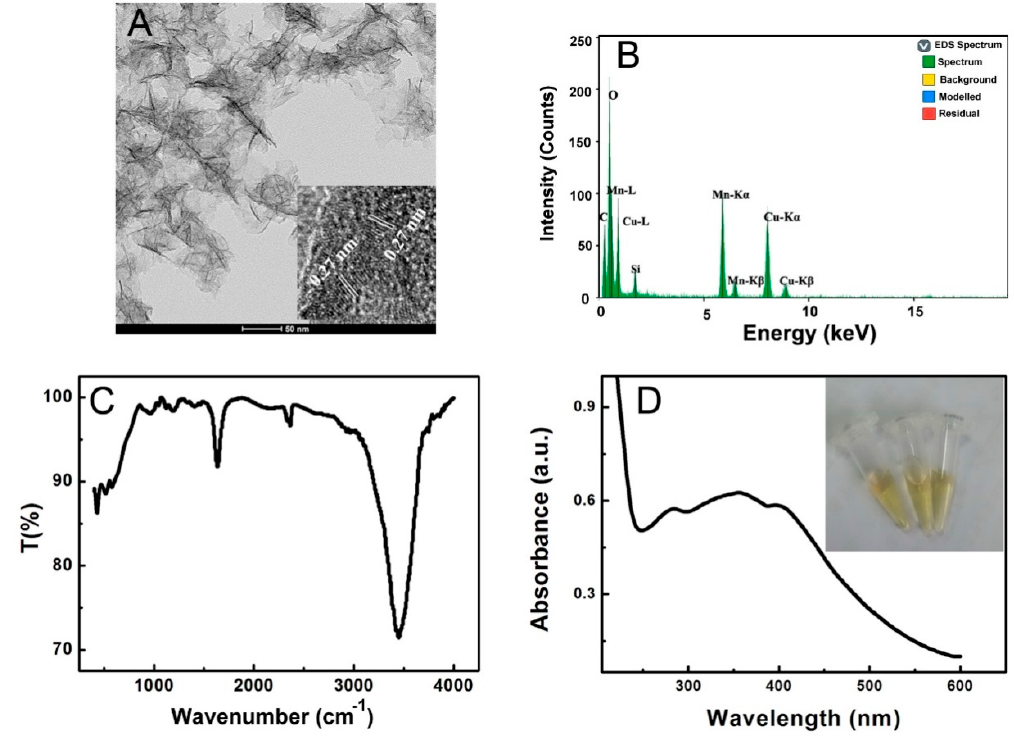
Figure 1. TEM image ( A ), EDS ( B ), FTIR spectrum ( C ) and UV-vis spectrum ( D ) of MnO 2 nanosheets. Inset of ( A , D ) showed the HRTEM of MnO 2 nanosheets ( A ) and dispersion pictures of MnO 2 nanosheets of three parallel operations ( D ), respectively.